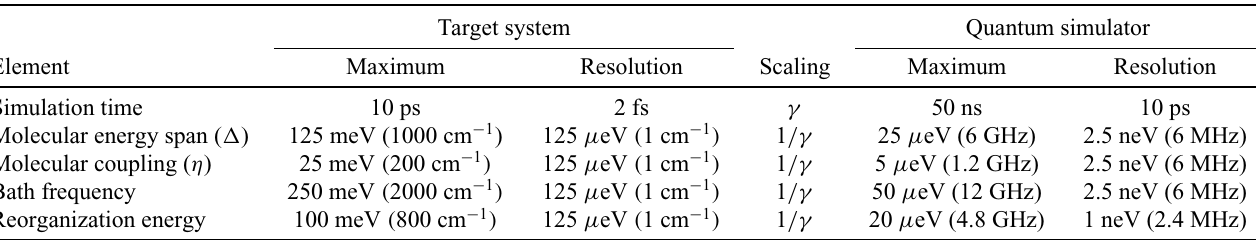
TABLE I. Typical ranges for physical parameters in energy or charge transport processes for photosynthetic complexes at T = 300 K and how they translate in the quantum simulator operating at cryogenic temperature T QS = 60 mK. The quantity γ = T / T QS = 5 × 10 3 denotes the ratio between temperatures of the target problem and the quantum simulator. Tuning of the temperature ratio can be used to map a wide range of target